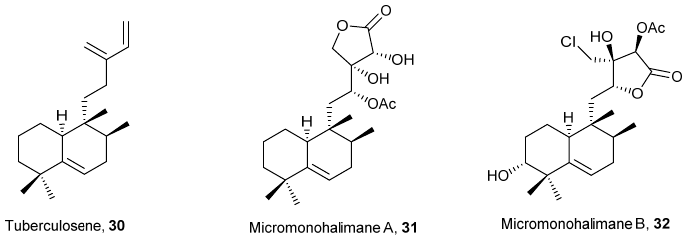
Figure 8. Some halimanes from bacteria